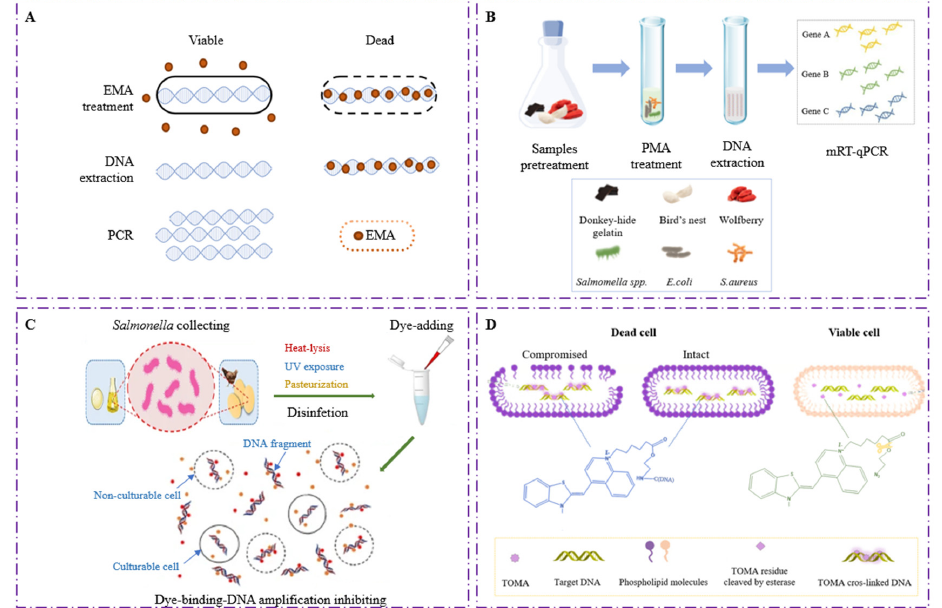
Figure 2. Schematic diagram of four nucleic acid intercalation dyes combined with PCR for distin- guishing and detecting viable and dead bacteria. ( A ) Principal diagram of EMA-PCR for detecting viable and dead bacteria based on cell membrane integrity [10]; ( B ) Flow chart of multiple real-time detection of viable bacteria by PMA-PCR [14]; ( C ) Flow chart of DyeTox13-PCR detection of viable bacteria in sterilized samples [16]; ( D ) Principal diagram of TOMA-PCR for detecting viable and dead bacteria based on enzyme activity [18]. The new nucleic acid intercalation dyes, DyeTox13 and TOMA, can correctly distin- guish the survival state of bacteria after various sterilization conditions and do not require Table 1. Comparison of different PCR techniques for detecting viable foodborne additional fluorescent dyes or probes, which can achieve the effect of visual detection by itself without additional fluorescent dyes or probes.